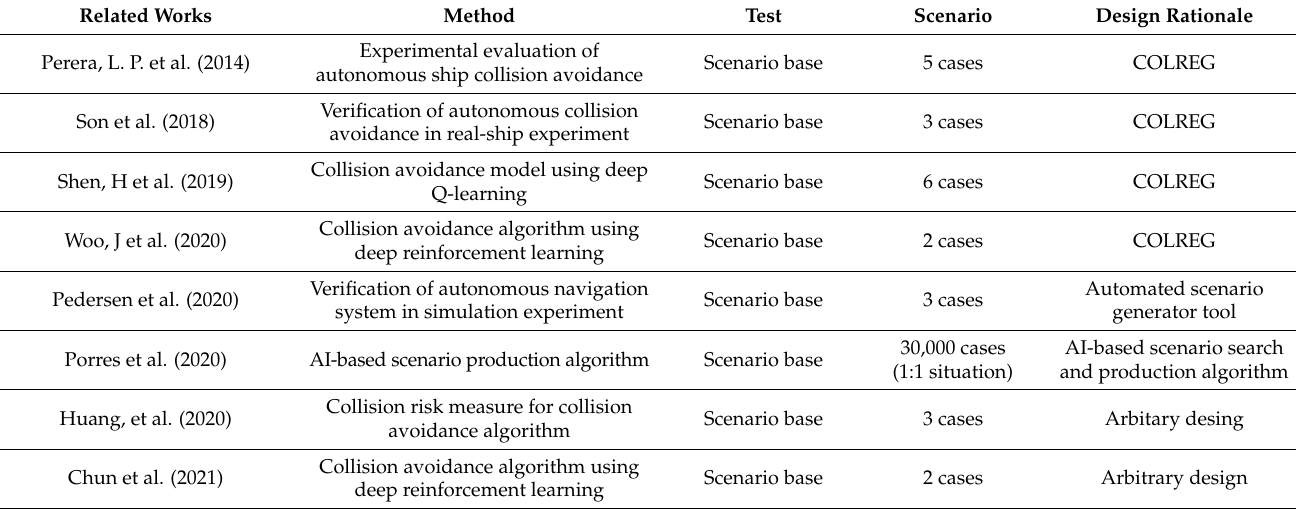
Table 1. Summary of related